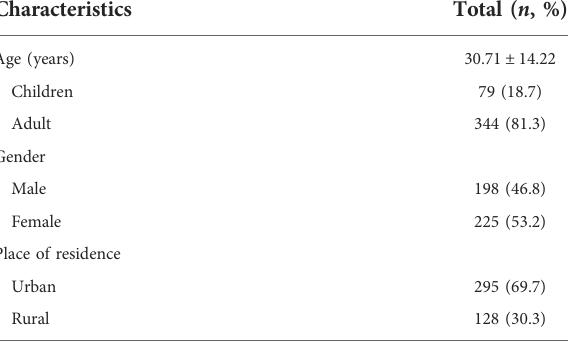
TABLE 1 Demographic characteristics of study subjects.